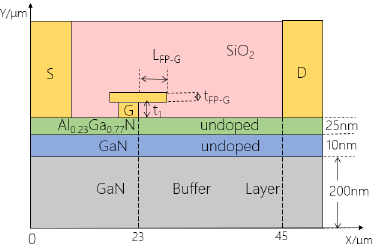
Figure 2. Device structure with FP-G analyzed in this study.